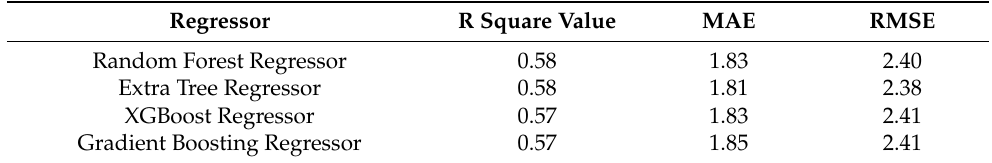
Table 4. R square value for